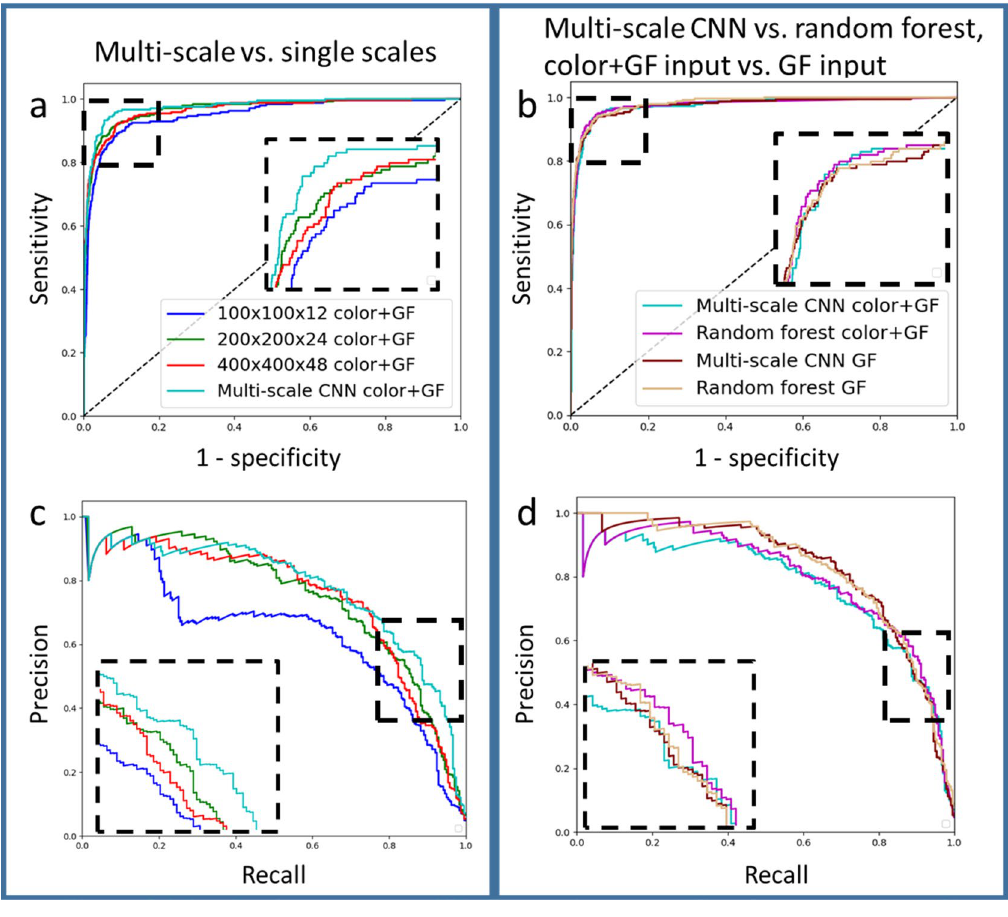
Figure 7. ROC and PRC show the effect of CNN size, color image as input, and random forest classifier configurations. ROC’s and PRC’s comparing CNNs with 100 × 100 × 12, 200 × 200 × 24, 400 × 400 × 48, and multi- scale color + GF input are shown in ( a ) and ( c ), respectively. Improvement with multi-scale is evident. ROC’s and PRC’s comparing multi-scale CNN vs. random forest and color + GF input vs. GF input are shown in ( b ) and ( d ), respectively. Random forest classifier with color + GF input is the best in the zoomed region. AUC values of ROC and PRC are shown in Table 2. The legends are the same between ( a ) and ( c ), ( b ) and ( d ).